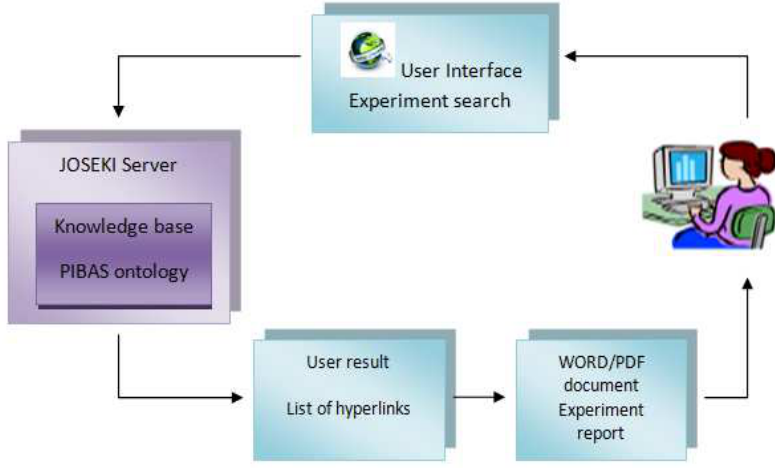
Figure 6. Architecture of system for experiment